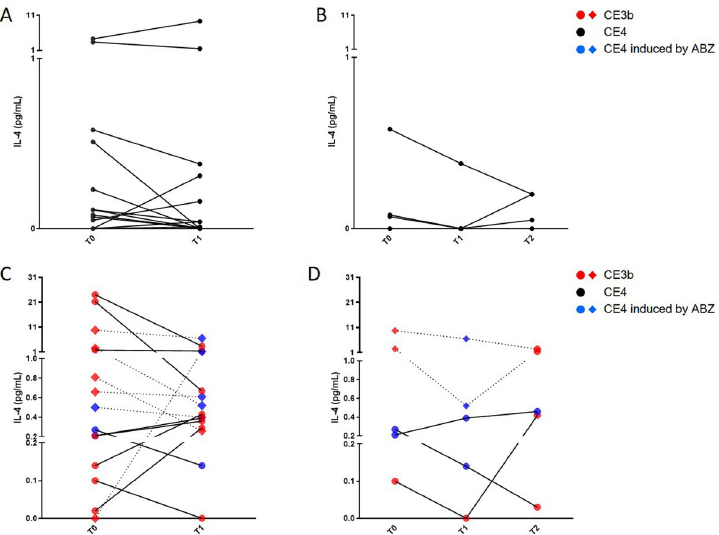
Fig 2. In the CE3b-group, the AgB-specific IL-4 response changed over time independently of therapy. Whole- blood test analysis at T1 (15 patients in the CE3b-group and in 14 patients in the CE4-group) and at T2 (5 patients in the CE3b-group and in 4 patients in the CE4-group). A. Analysis of IL-4 levels in the CE4-group at T1 compared to T0. B. Analysis of IL-4 levels in the CE4-group at T2 compared to T0 or T1. C. Analysis of IL-4 levels in the CE3b- group at T1 compared to T0. IL-4 levels decreased in 6 patients, increased in 2, and were unchanged in 7 patients at T1 compared to T0. The treatment led to cyst solidification (CE4 at T1) in 4/5 of patients with CE3b at T0: 2 patients showed a IL-4 decline; one patient showed almost no change and one patient showed an increase. D. Analysis of IL-4 levels in the CE3b-group at T2 compared to T0 or T1. At T2, 3/4 with CE4 cysts at T1 had their cysts reactivated to CE3b stage and IL-4 levels increased at T2 only in 1 of them. Footnotes: IL-4 concentrations were determined by ELISA. Responses in all the panels were compared using the Wilcoxon test; differences were considered significant at p-values of � 0.05. Red dots indicate patients with CE3b cysts, blue dots indicate patients with treatment-induced CE4 cysts, black dots indicate patients with spontaneously-inactivated cysts, diamond symbols indicate that the patient received albendazole.The continuous lines indicate that no treatment was administered; dotted lines indicate albendazole between the 2 time points. IL: Interleukin; CE: Cystic Echinococcosis; ABZ: Albendazole. IL-4 levels at T2 did not significantly change (p = 0.43) with the exception of 1 patient who showed a 66% decrease from T0 to T2 (Fig 2B).